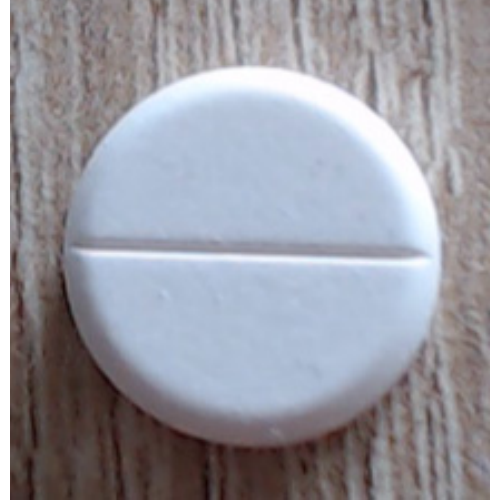
Figure 1. Paracetamol pill (500 mg).